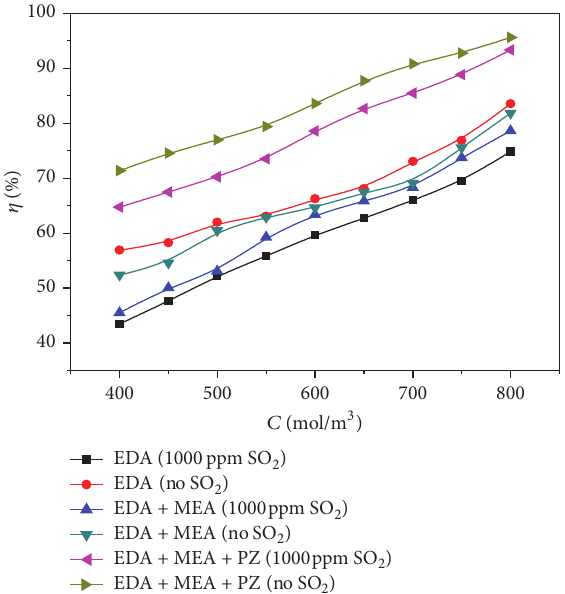
Figure 7: Influence of SO 2 on the CO 2 removal efficiency in different concentrations of absorbent ( 𝑈 𝑔 = 4 m 3 /h, U and T = 288 K).